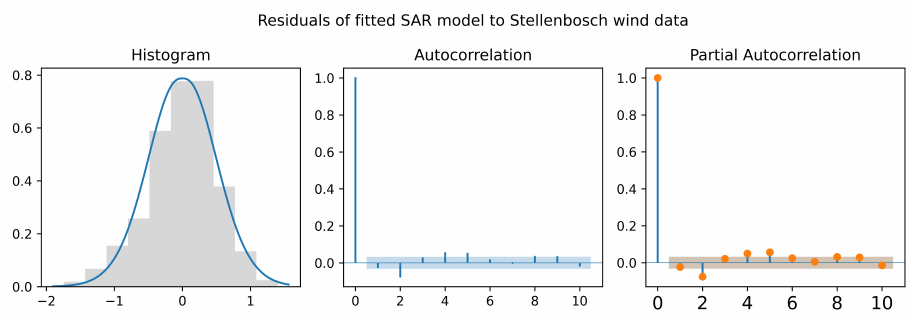
Figure 9. Timeplot, ACF, and PACF of residuals for fitted seasonally adjusted autoregressive